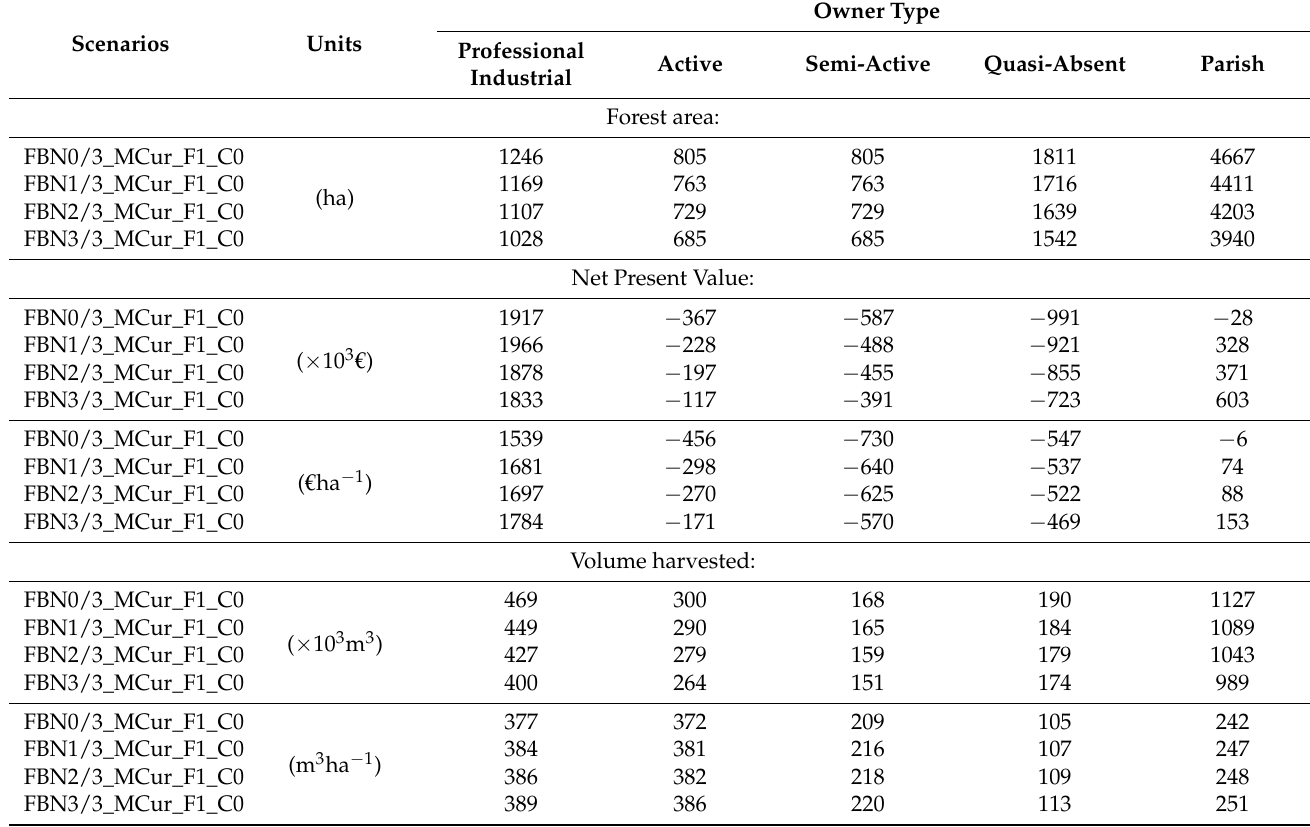
Table 6. Total and per hectare values for NPV and volume harvested by owner type for the BAU (FBN0/3_MCur_F1_C0) and for the scenarios reflecting the three FBN priority levels (FBN1/3_MCur_F1_C0, FBN2/3_MCur_F1_C0, and